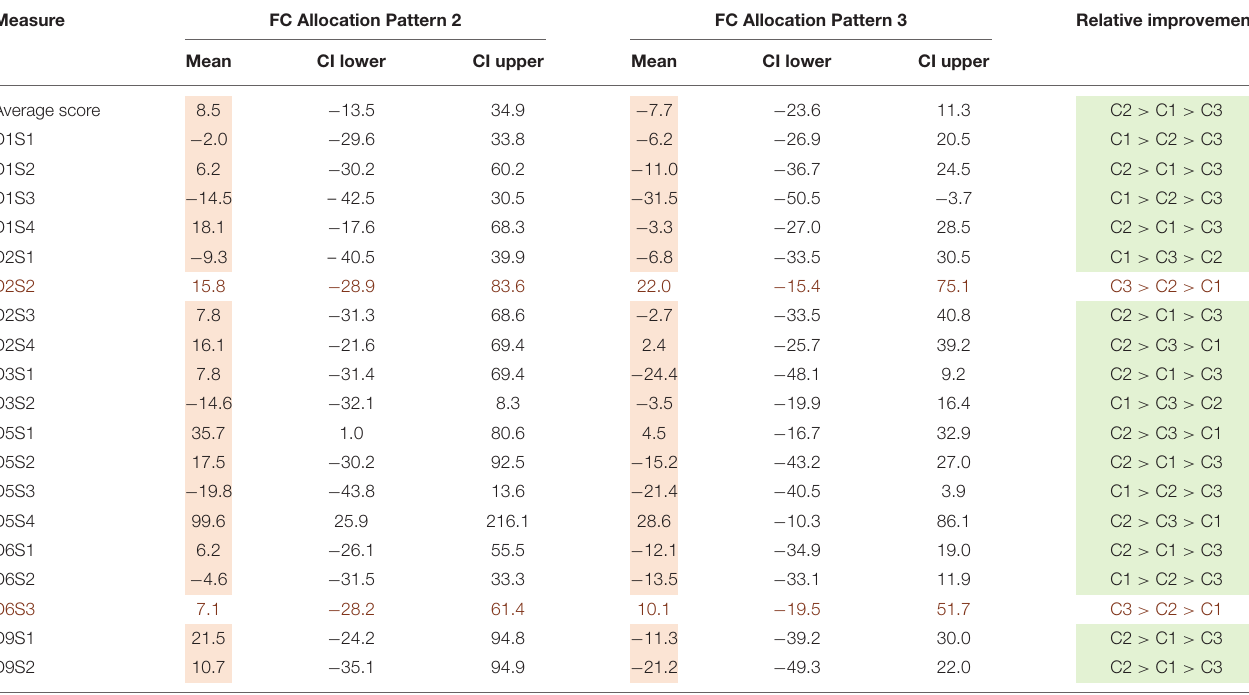
TABLE 5 | Bayesian estimates for percent change (with 95% credible interval) in performance score with change in FC Allocation Pattern 2 and Pattern 3 relative to Pattern 1. Measure FC Allocation Pattern 2 FC Allocation Pattern 3 Relative